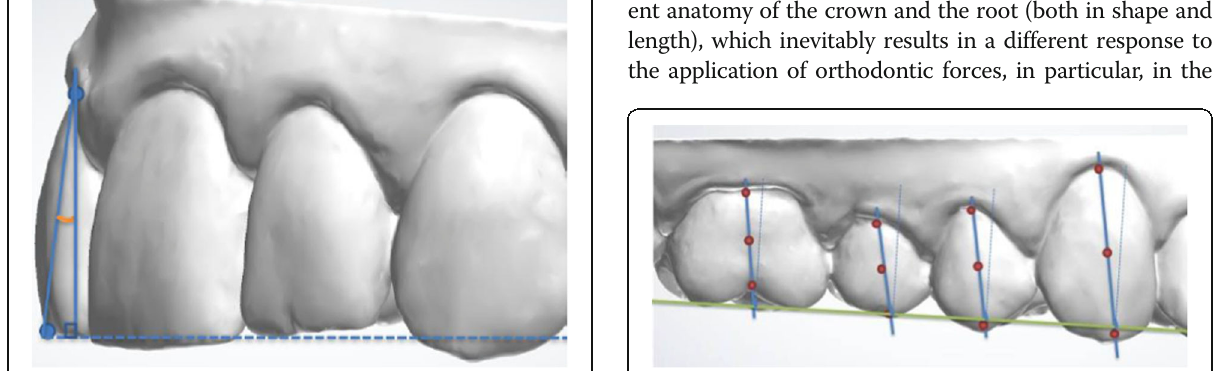
Fig. 2 Vestibulolingual tipping: labiolingual inclination of the FACC with respect to the occlusal plane of reference